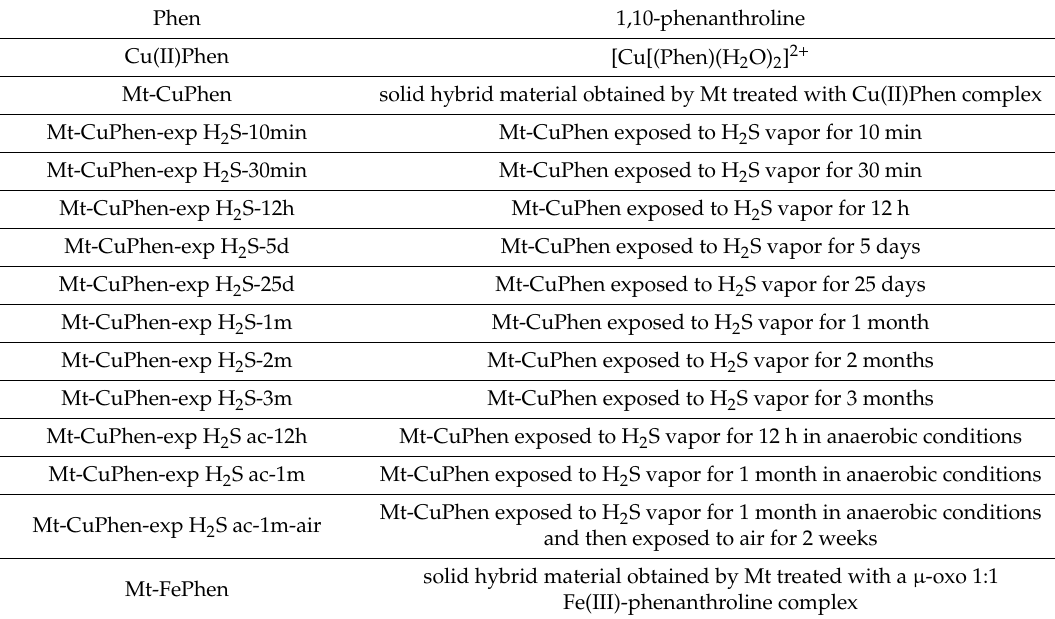
Table A1. The list of